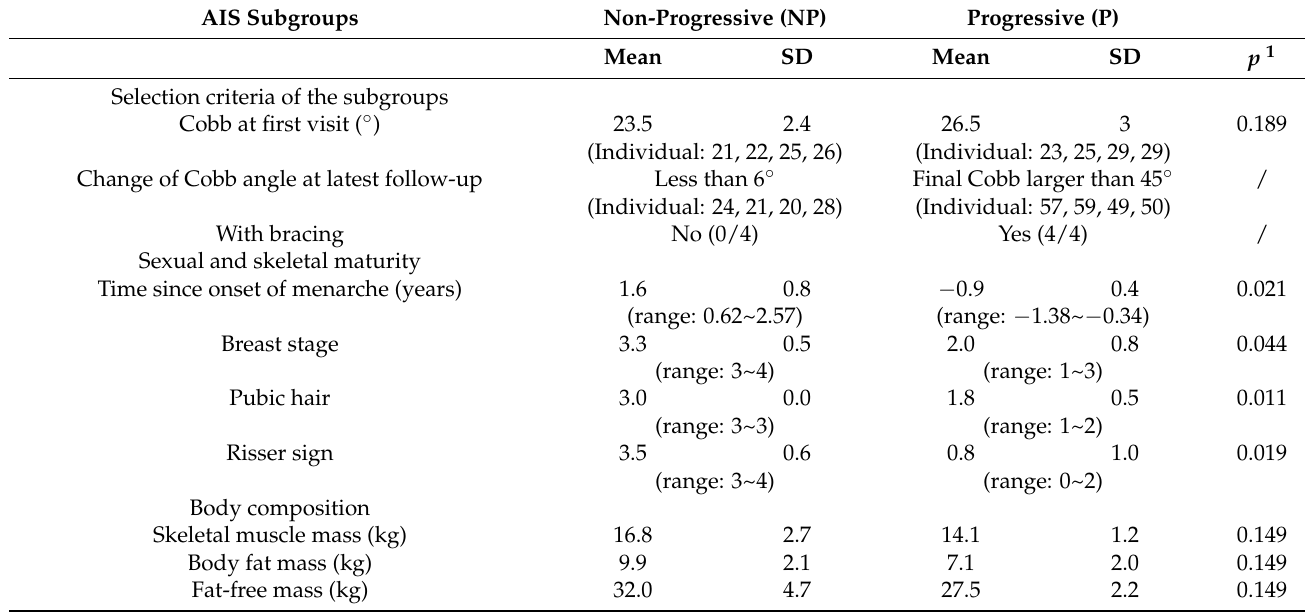
Table 2. Selection criteria for the AIS subgroups and the subjects’